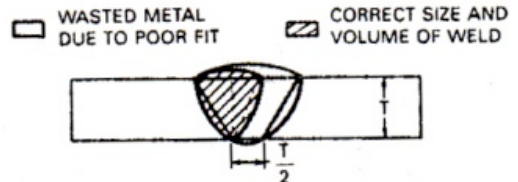
5.1 Present state of design and performance (manual manner, overwelding)